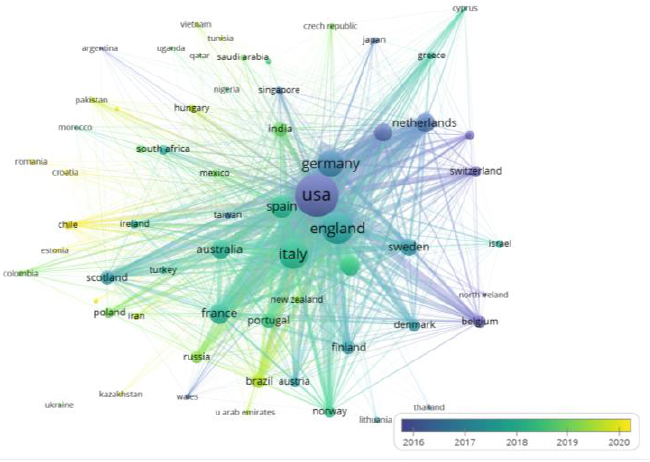
Figure 4. Overlay visualisation of countries ’ citations (VOSviewer).